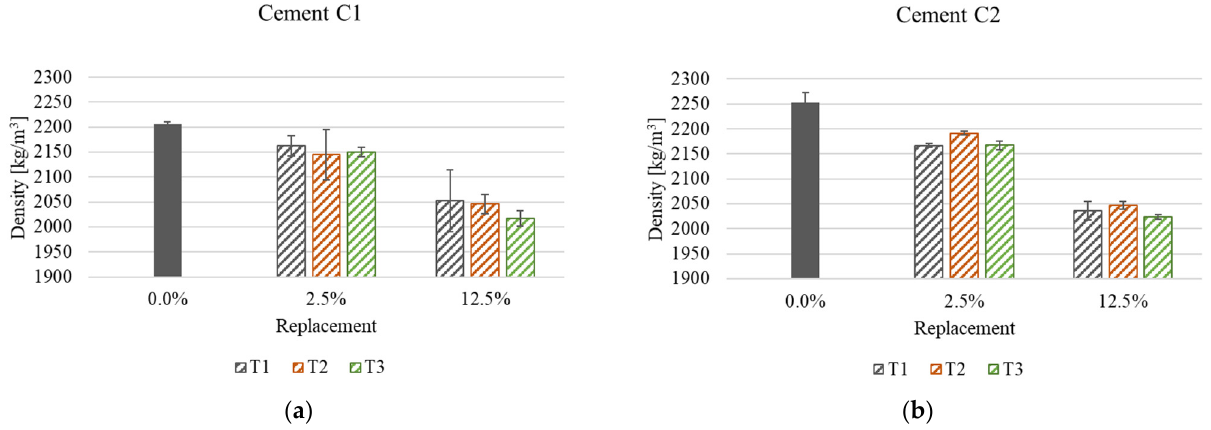
Figure 5. Density of mortar with addition of untreated rubber 2.5% and 12.5% replacement: ( a ) cement C1; ( b ) cement